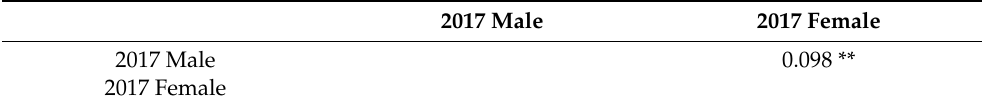
Table 6. The Spearman’s rank correlation coefficient of female and male strobilus productions